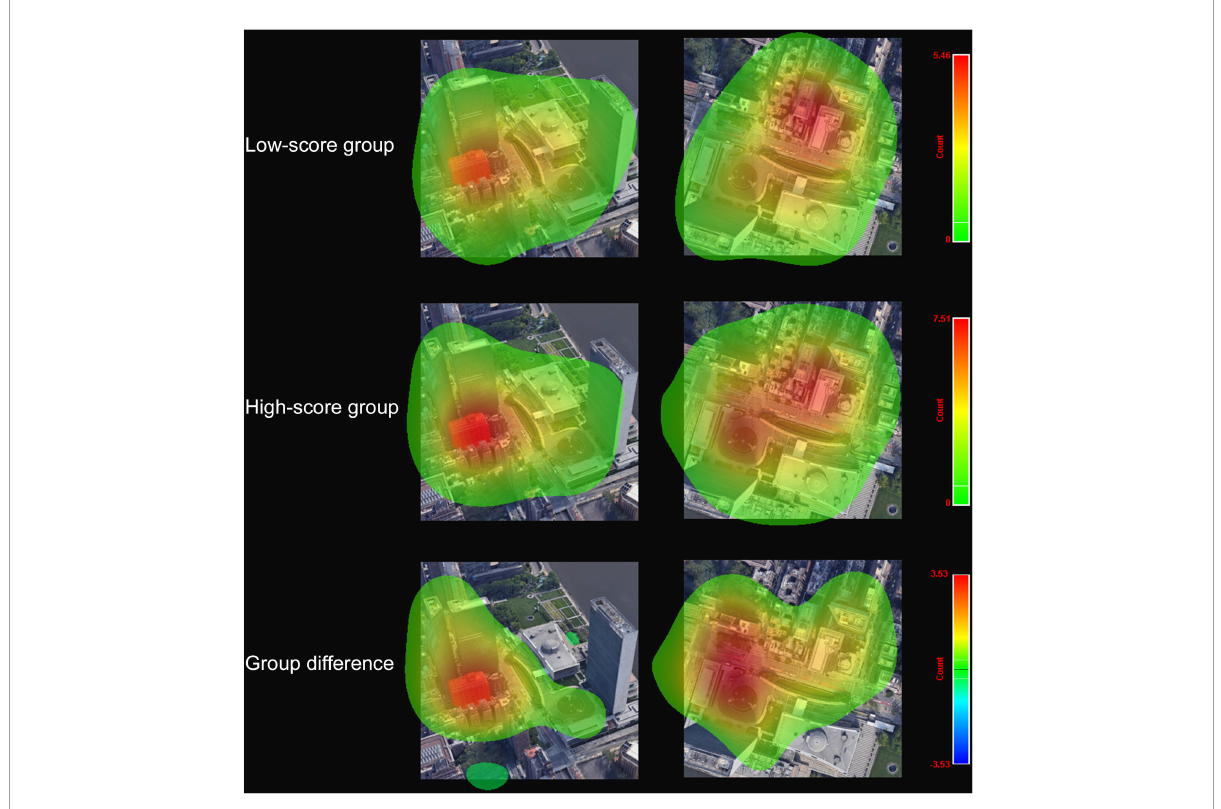
FIGURE4 Eye-tracking heatmap of fixation count. The redder the color, the higher the number of fixation count when performing target finding task.